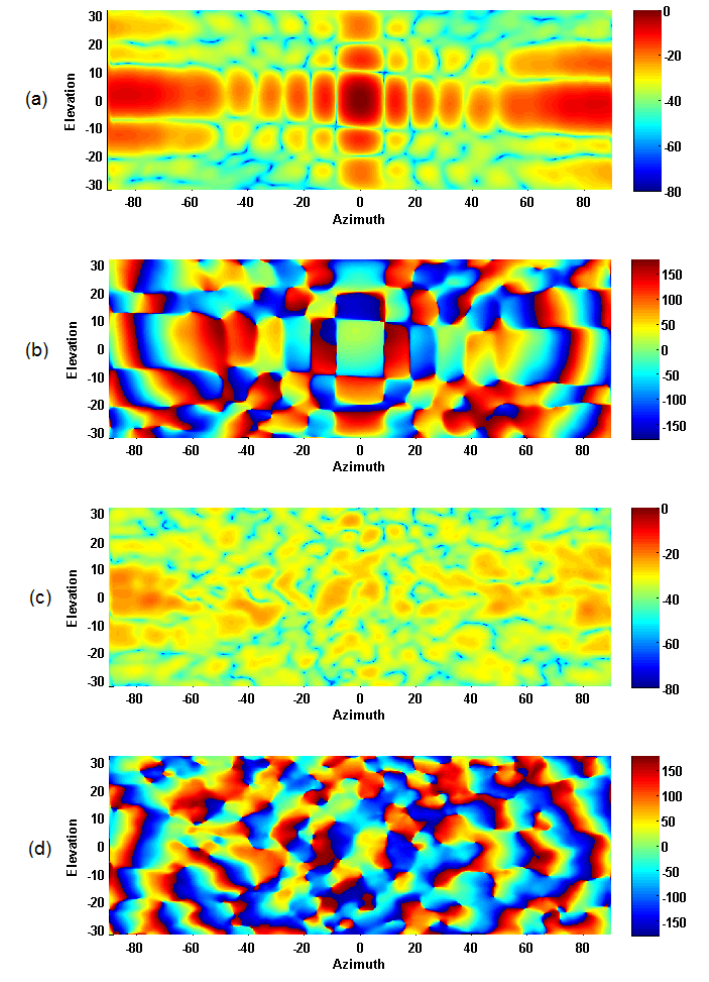
Figure 14. Measured patterns of an eight-by-eight faceted-cylindrical phased array antenna (based on AEPs and software-calibration) ( a ) co-polar magnitude in dB; ( b ) co-polar phase in degrees; ( c ) cross-polar magnitude in dB; and ( d ) cross-polar phase in